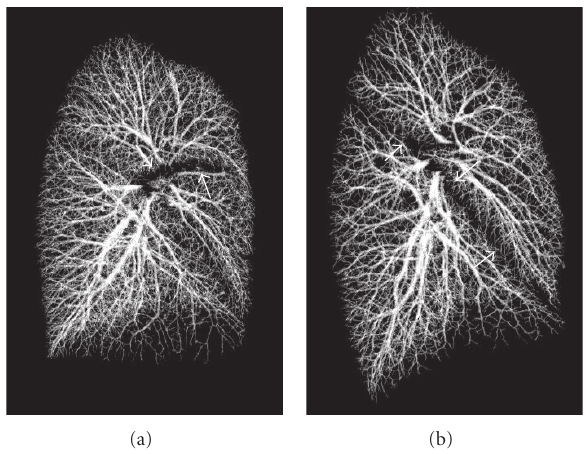
Figure 9: The extracted vascular tree of the right lung. Horizontal fissure is recognizable by the sparse region of the vascular tree in (a). Similarly, void region of the vascular tree describes the existence of oblique fissure in